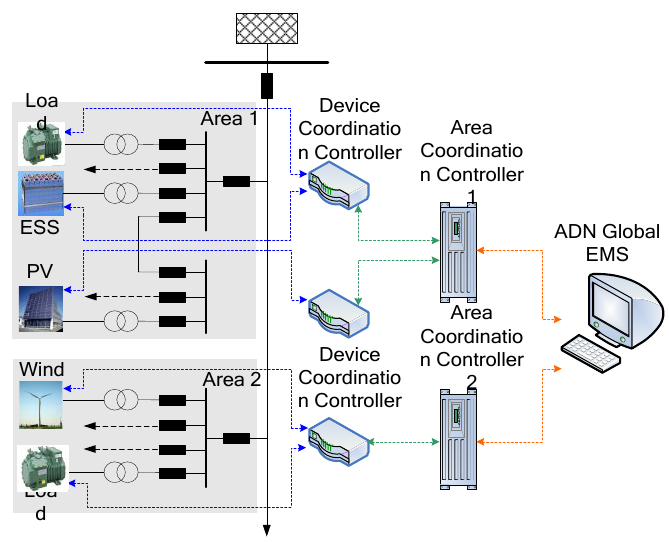
Figure 3. Control system of Active Distribution Network (ADN). Table 1. The problems of Active Distribution Network and solution based on Cyber Physical Systems (CPS).